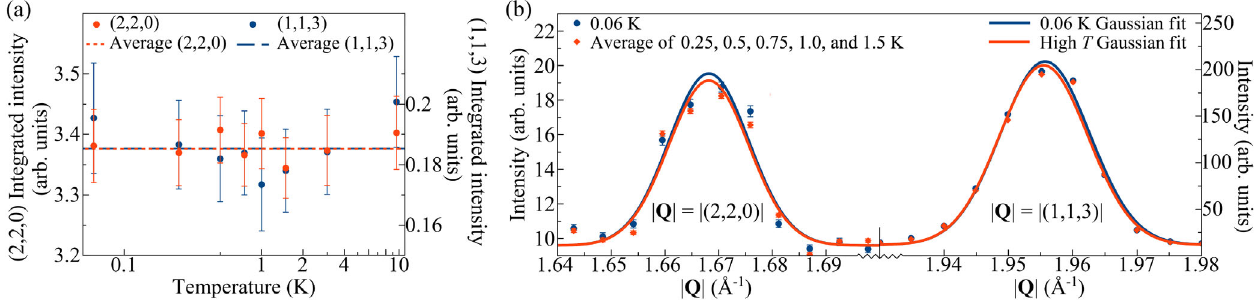
FIG. 14. (a) The temperature dependence of the integrated intensity for the Bragg peaks at the Q ¼ ð 2 ; 2 ; 0 Þ (red) and Q ¼ ð 1 ; 1 ; 3 Þ (blue) positions. No significant temperature dependence is discernible. (b) Elastic Q cuts through the Q ¼ ð 2 ; 2 ; 0 Þ (left) and Q ¼ ð 1 ; 1 ; 3 Þ (right) positions at T ¼ 0 . 06 K (blue) and averaged over the higher temperature data points T ¼ 0 . 25 , 0.5, 0.75, 1, 1.5 K (red). The Gaussian fitting to each of these datasets, used to determine a corresponding integrated intensity, is also shown for each Bragg peak in (b). From these integrated intensities, we conclude that no AIAO dipole order occurs in Ce 2 Zr 2 O 7 , with an upper limit on the Ce 3 þ ≤ 0 . 04 μ ordered moment of μ B ordered